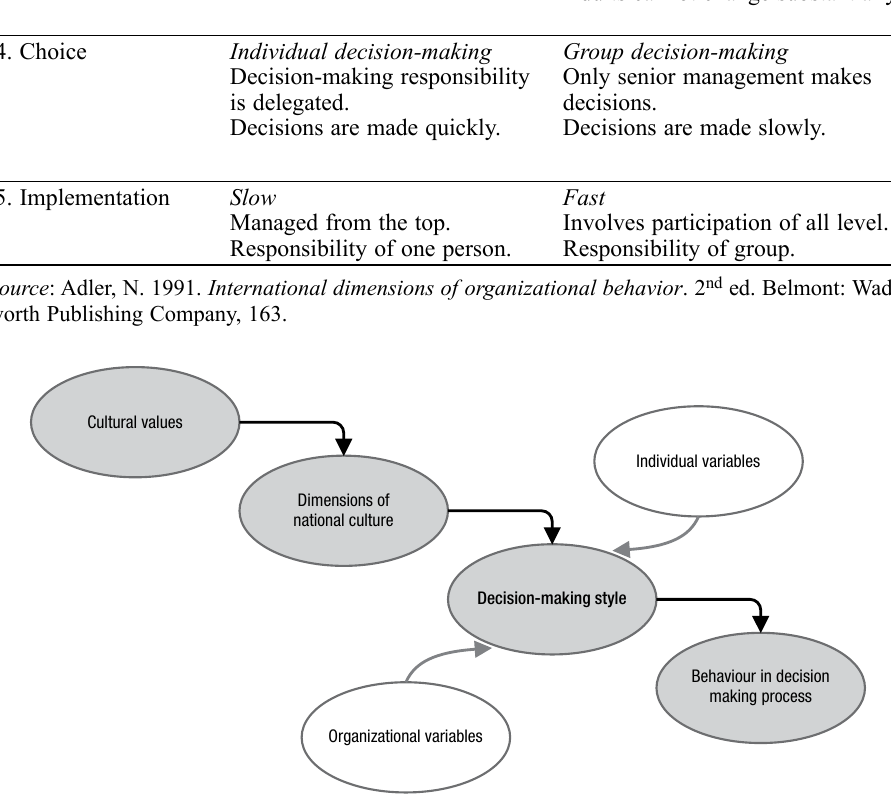
Fig. 1. Model of the variables influencing decision-making style